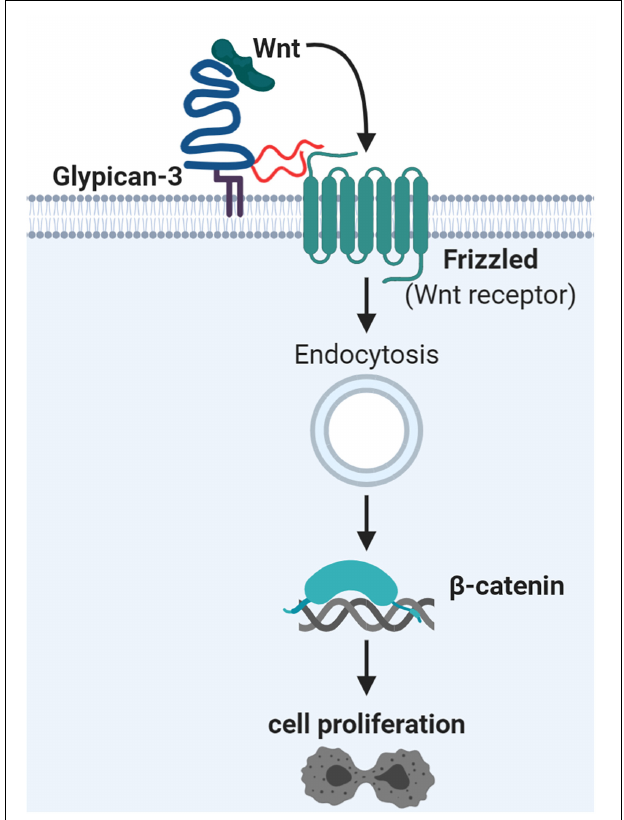
FIGURE 3 | Glypican-3 signaling supports Wnt signaling and hepatocellular proliferation. Glypican-3 (shown in blue) can carry two glycosaminoglycan chains of heparan sulfate (HS; in red) or chondroitin sulfate (CS; not shown). It has been determined that these glycosaminoglycan chains are essential for interaction with Frizzled proteins, the Wnt receptors, but not for Wnt ligand binding. The ternary complex of glypican-3, Frizzled, and Wnt ligand becomes endocytosed as part of canonical Wnt signaling. This leads to nuclear accumulation of β -catenin and subsequent gene expression changes, stimulating cell proliferation. Details and references are given in the main